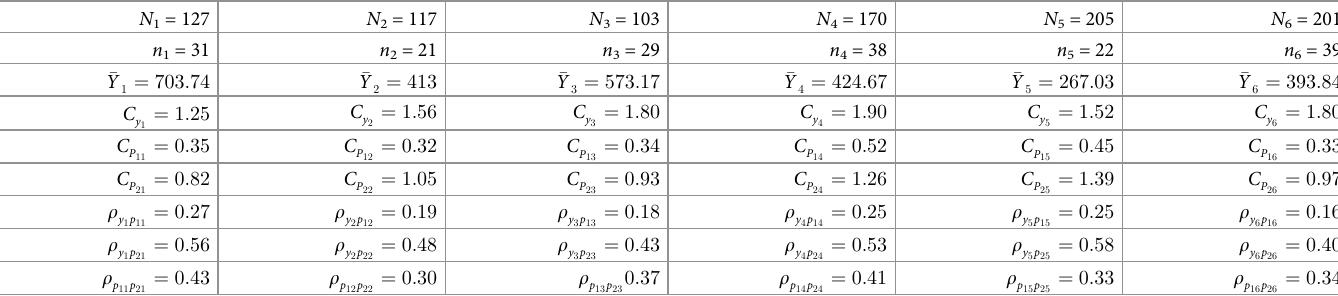
Table 7. Summary statistics of population 3.